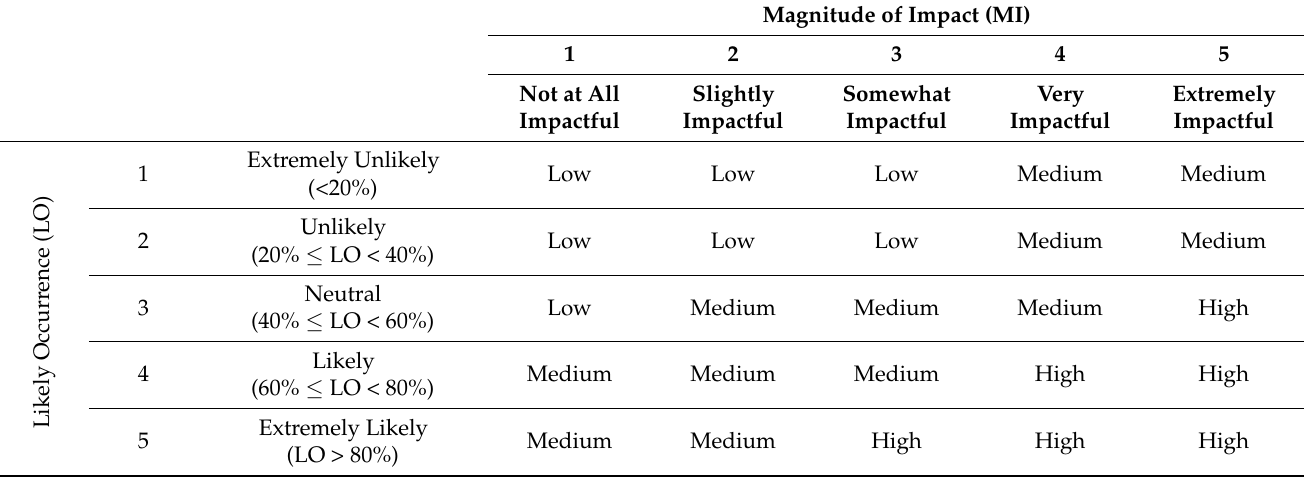
Table 2. Risk impact–probability